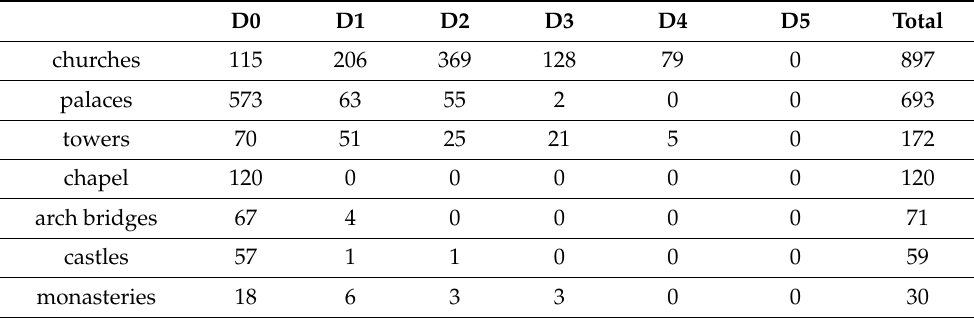
Table 8. Number of buildings and structures damaged at different damage levels D k (k = 0–5) of the EMS-98 damage scale resulting from the ARCH DSS simulation of the Visso earthquake